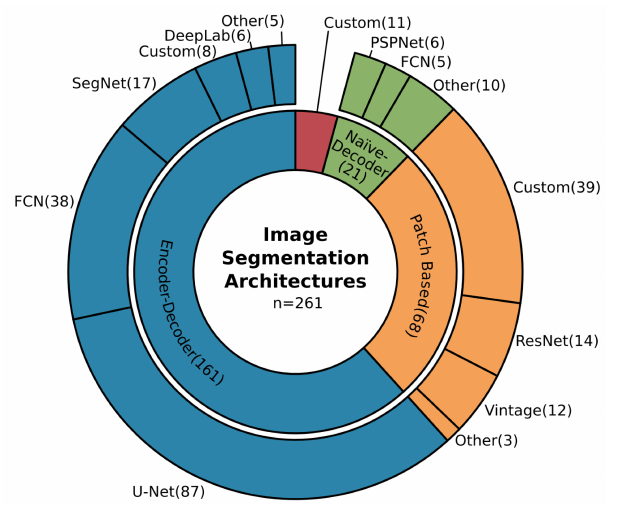
Figure 6. Overview of the commonly employed architectures for image segmentation in the field of remote sensing. Of the four most common encoder–decoder architectures, three were implemented: U-Net, SegNet, and DeepLab. Source: